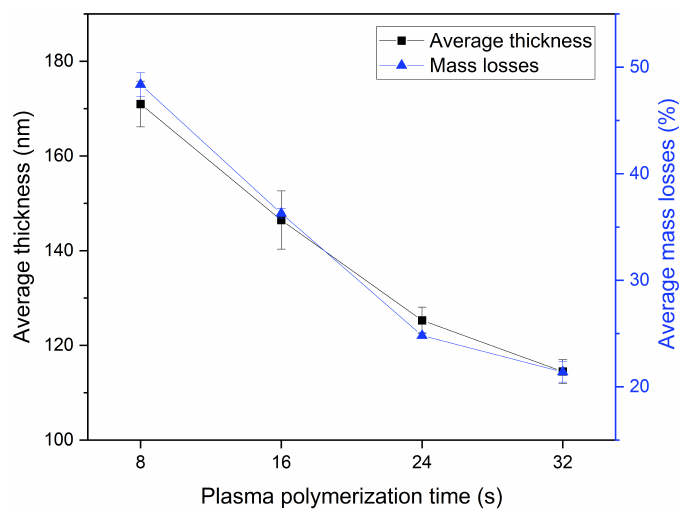
Figure 8. Average thickness (as-deposited) and mass losses of pp films for different plasma polymer- ization treatment times, at S30 and misting time of 6